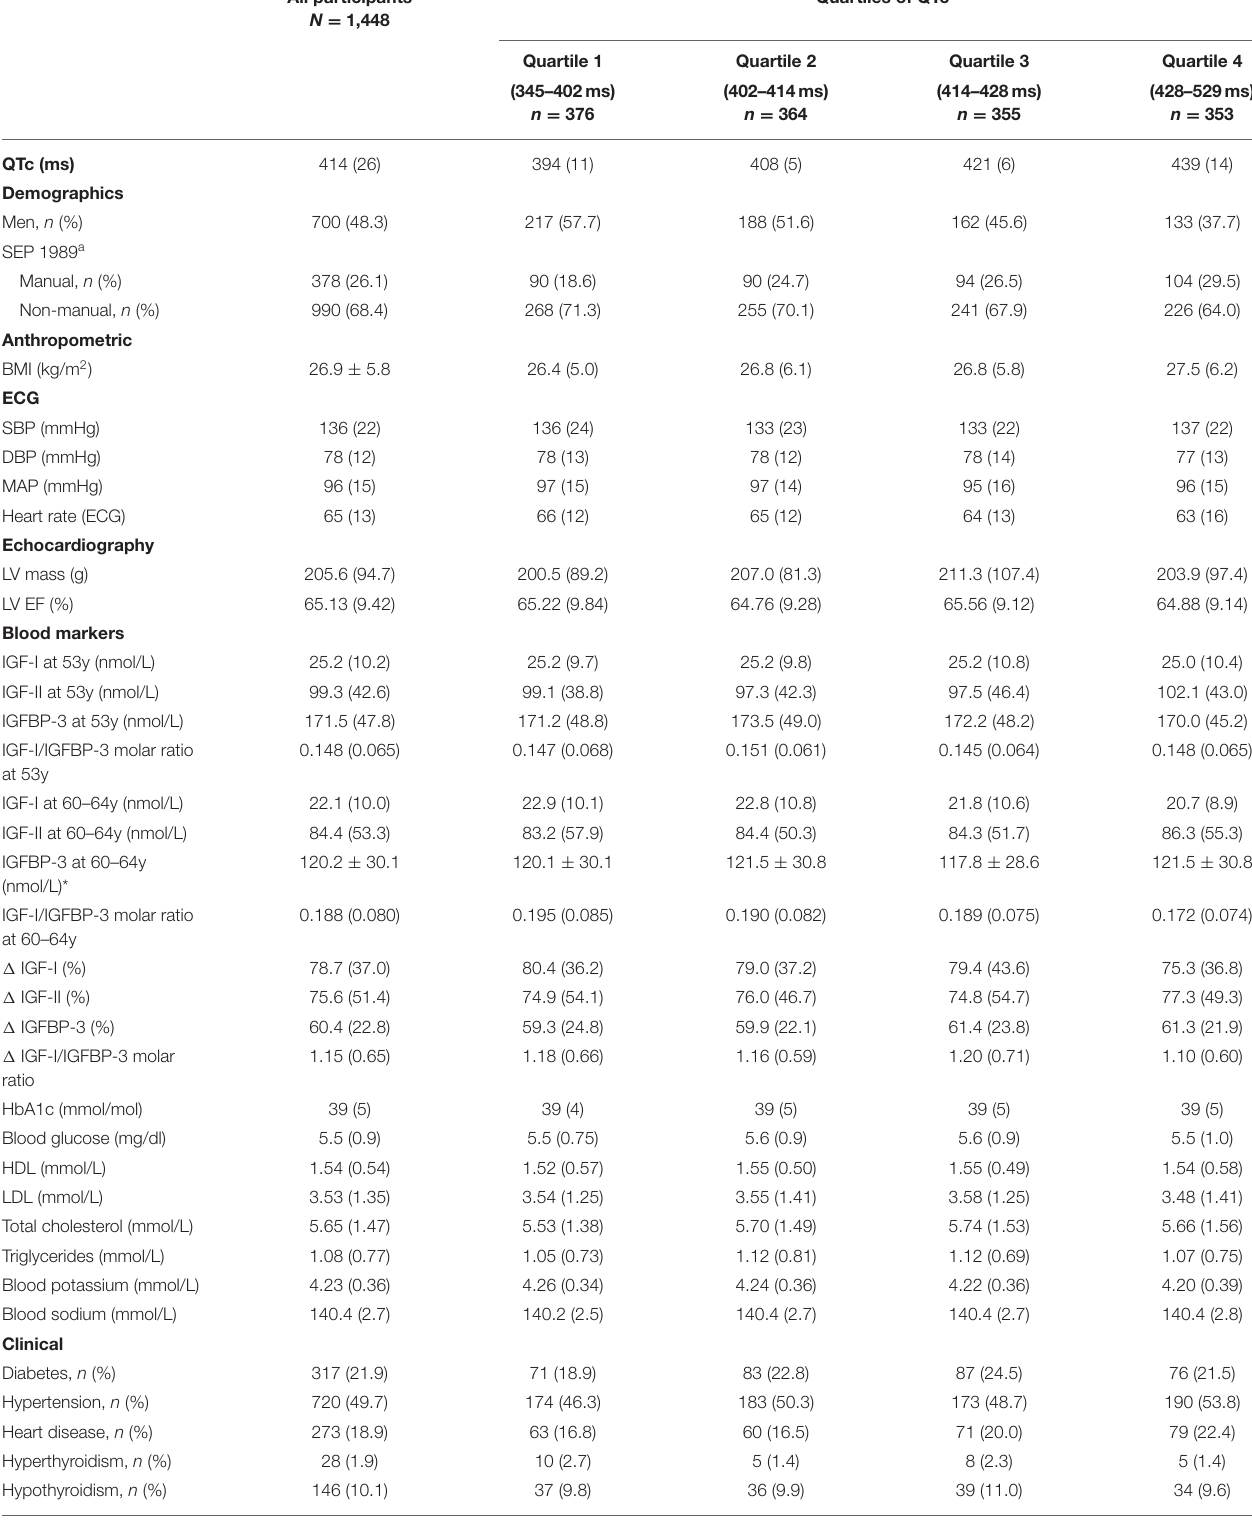
TABLE 1 | Participant characteristics across the quartiles of